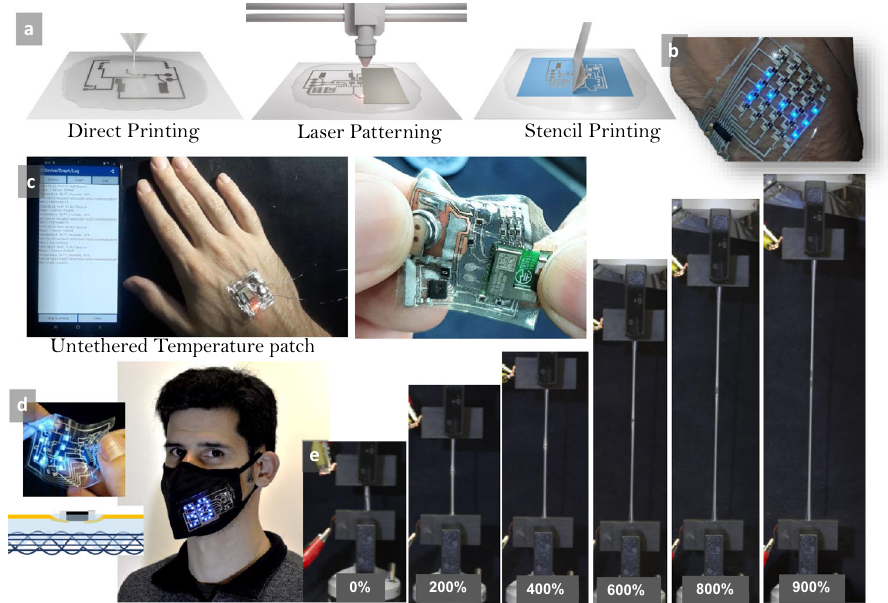
Fig. 6 Circuit patterning techniques and examples of applications. a Soft-matter circuit with Ag – In – Ga – SIS ink can be produced by extrusion printing, fi ber laser patterning, or stencil printing. b Example of an LED display with 60 integrated chips fabricated by extrusion printing and vapor exposure. c An untethered wireless temperature patch with integrated Bluetooth chip, temperature and humidity sensor, microprocessor, resistors, and battery, produced through laser patterning and vapor exposure. The patch sends the data to the mobile phone app. d A condensed soft-matter circuit with temperature sensor and LED display matrix, transferred to the textile through the same Pol – Gel procedure. During the gel state, the SIS substrate penetrates into the fi bers of the e-textile, resulting in seamless integration. e Example of a sample with a resistor chip <0 – 900% strain. The authors af fi rm that the human research participant ( fi rst author P.L.) provided informed consent for publication of the images in ( b – d